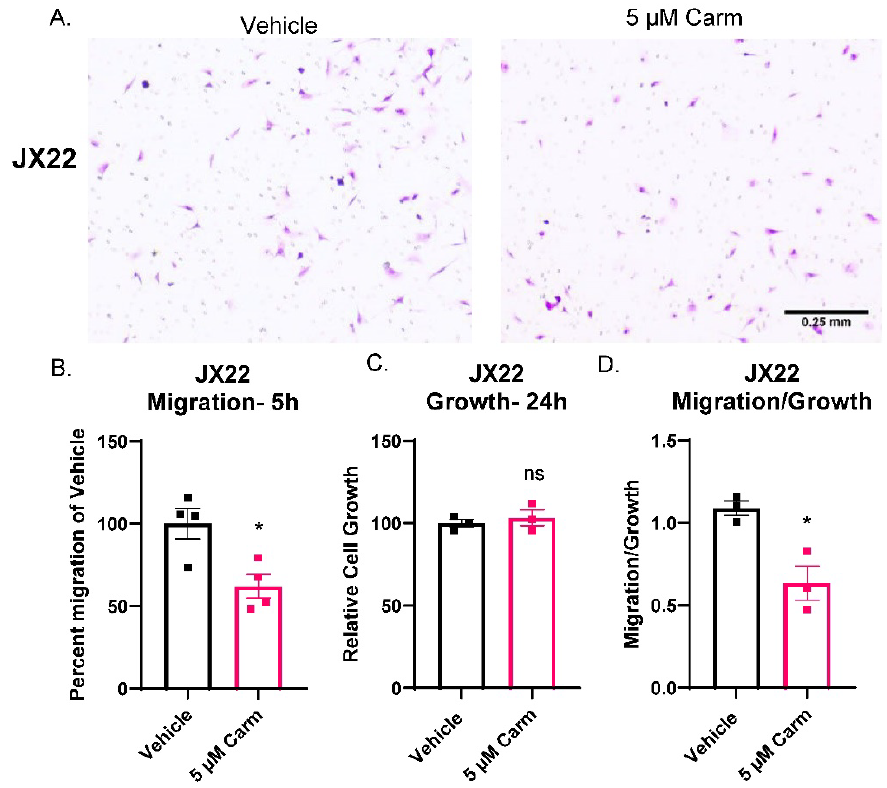
Figure 5. Carmofur decreased migration of PDX-derived GBM cells. Cells were serum-starved in the presence of vehicle (DMSO) or 5 µ M carmofur 16 h prior to migration assay. At the time of assay, cells were plated at 50,000 cells/insert for the Boyden chamber assay on top of BTIC with 2 × EGF/FGF and 2% FBS as the chemoattractant. At the same time, cells were plated at 5000 cells/well for matching growth assay. ( A ) Representative images of crystal violet-stained migration inserts from carmofur-treated JX22 GBM cell migration in Boyden chamber assays are shown. ( B ) Images were quantified using the cell count function on PICO Imagepress. ( C ) Matching growth was analyzed by Cell Titer Glo and normalized to vehicle control. ( D ) Percent migration was divided by the relative cell growth to determine the ratio of migration to growth. Data are displayed as means ± SEM. Not significant (ns), * p < 0.05 with independent t -test ( n =